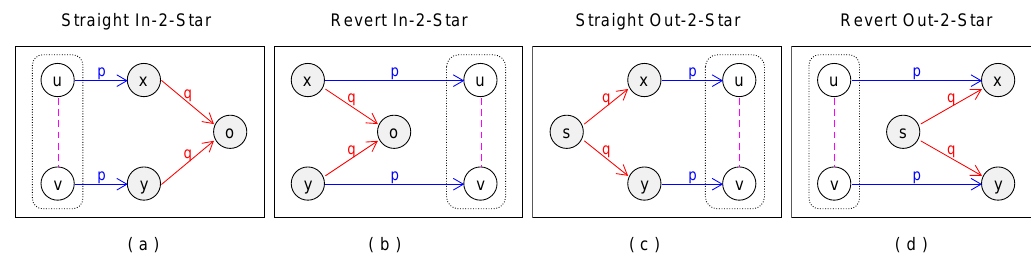
Figure 6. Extraction patterns with two predicates and four triples. ( a ) Straight In-2-Star: u and v have out-going connections (using p ) to x and y , respectively, while x and y have out-going connections (using q ) to o . ( b ) Revert In-2-Star: u and v have in-coming connections (using p ) from x and y , respectively, while x and y have out-going connections (using q ) to o . ( c ) Straight Out-2-Star: u and v have in-coming connections (using p ) from x and y , respectively, while x and y have in-coming connections (using q ) from s . ( d ) Revert Out-2-Star: u and v have out-going connections (using p ) to x and y , respectively, while x and y have in-coming connections (using q ) from s